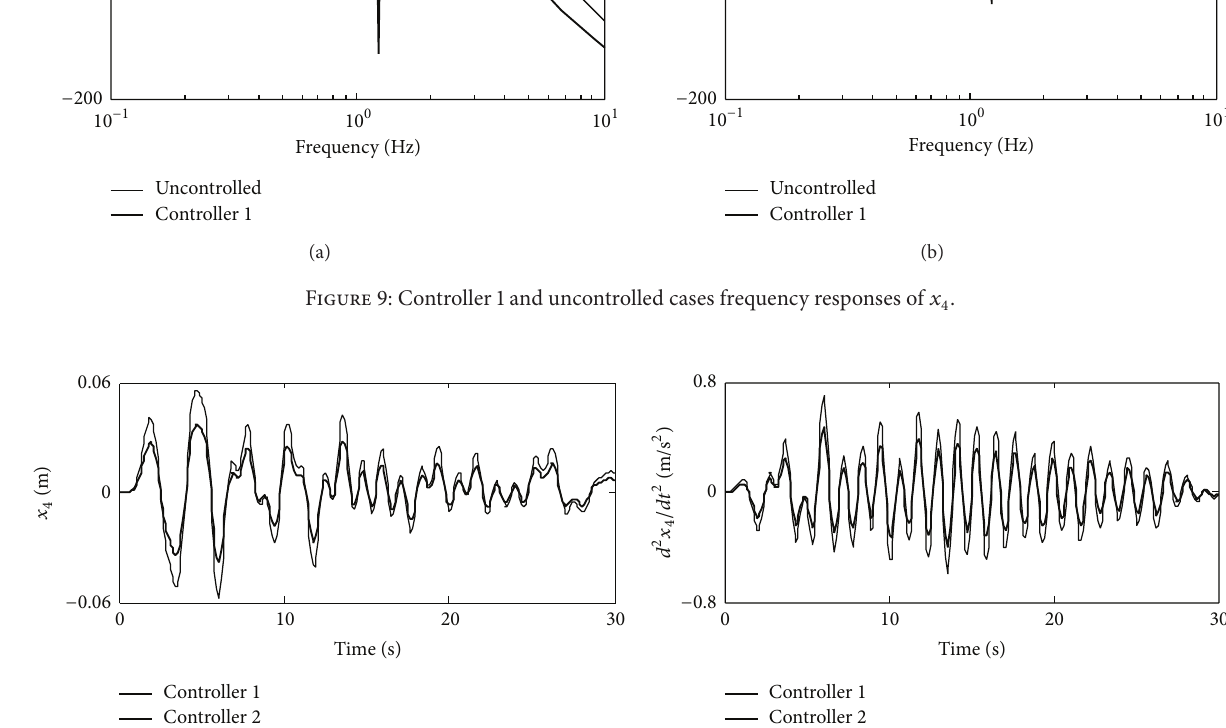
Figure 10: Comparison of time responses of the 𝑥 4 for controllers cases (El Centro